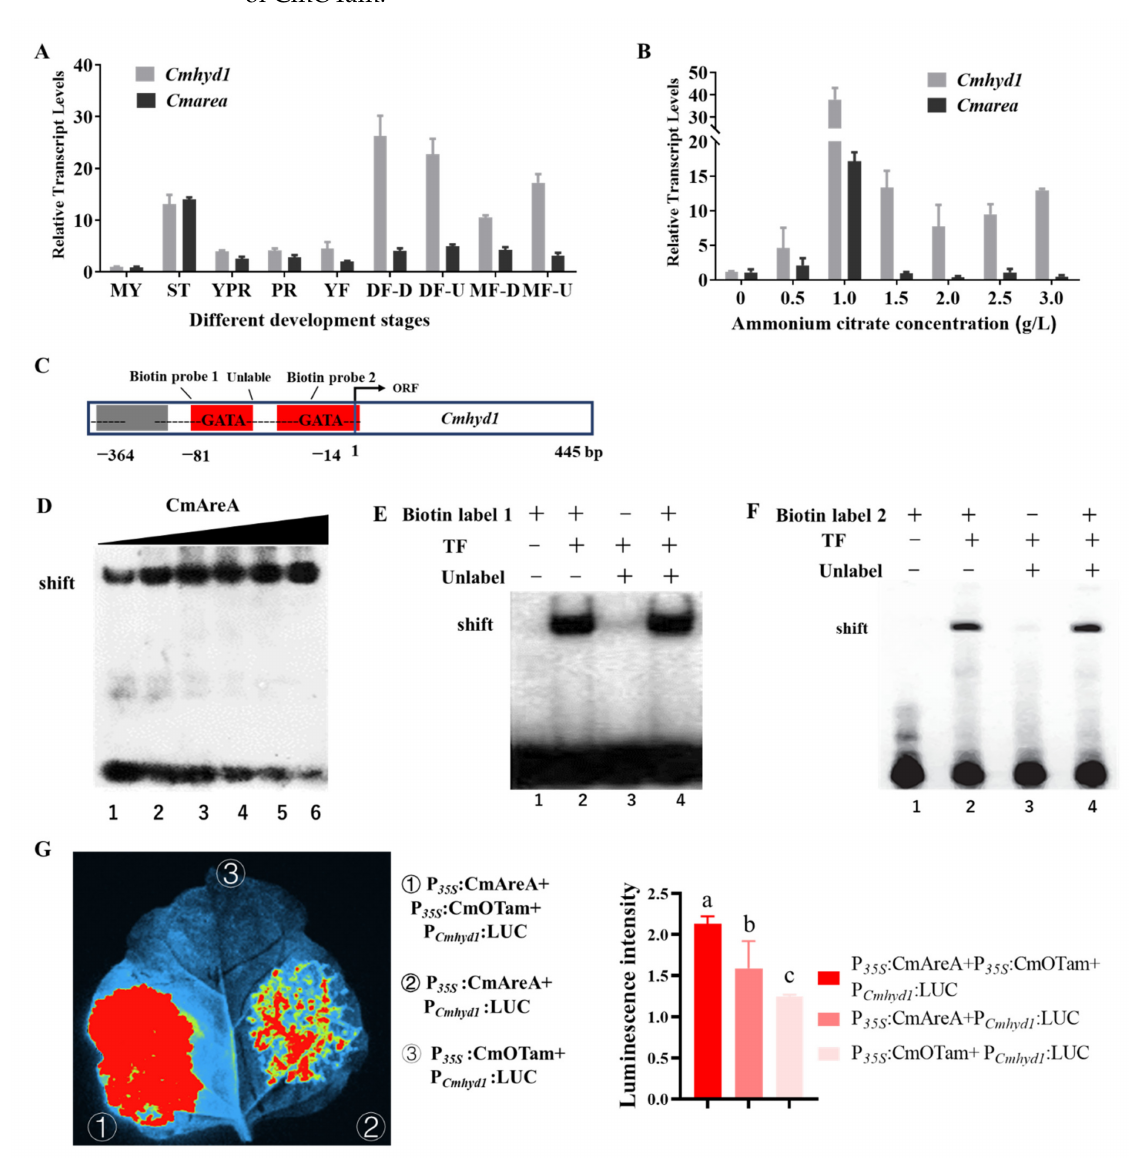
Figure 7. The transcription factor CmAreA was recruited to the promoter and activated the transcript of of Cmhyd1 . ( A ) The relative transcript levels of Cmhyd1 and Cmarea at different developmental stages. MY: mycelium used for inoculation of silkworm pupae; ST: sclerotium (mummified silkworm pupae) before stroma development; YPR: mycelium knot tissue before stroma development; PR: sclerotium with initial stroma (stroma < 1 cm); YF: sclerotium with early stage stroma (1 cm < stroma < 2 cm); DF: sclerotium with developed stroma (stroma > 5 cm); MF: mature fruiting body. The results were based on the standard levels of the MY stage. ( B ) The relative transcript levels of Cmhyd1 and Cmarea at primordial stage of WT with different concentrations of ammonium citrate. ( C ) The schematic diagram showing the predicted GATA-binding elements in the promoter region of Cmhyd1 . The transcription start sites are indicated as “1”. ORF: open reading frame. Biotin probe: the biotin probe for EMSA. Unlabel: negative control for EMSA. ( D ) Characterization of CmAreA interaction with GATA-binding site by EMSA. A 50 bp Cmhyd1 promoter probe was incubated with a quantity of CmAreA protein (400 ng, 600 ng, 800 ng, 1000 ng, 1500 ng or 3000 ng). With the increase in the amount of CmAreA, a greater DNA shift was observed with less free probe accumulation at the bottom. ( E , F ) CmAreA can bind to the two GATA sequences in the Cmhyd1 promoter by EMSA. ( E , F ) The results of probe 1 and 2, respectively. The labeled DNA probe 1 or 2 was